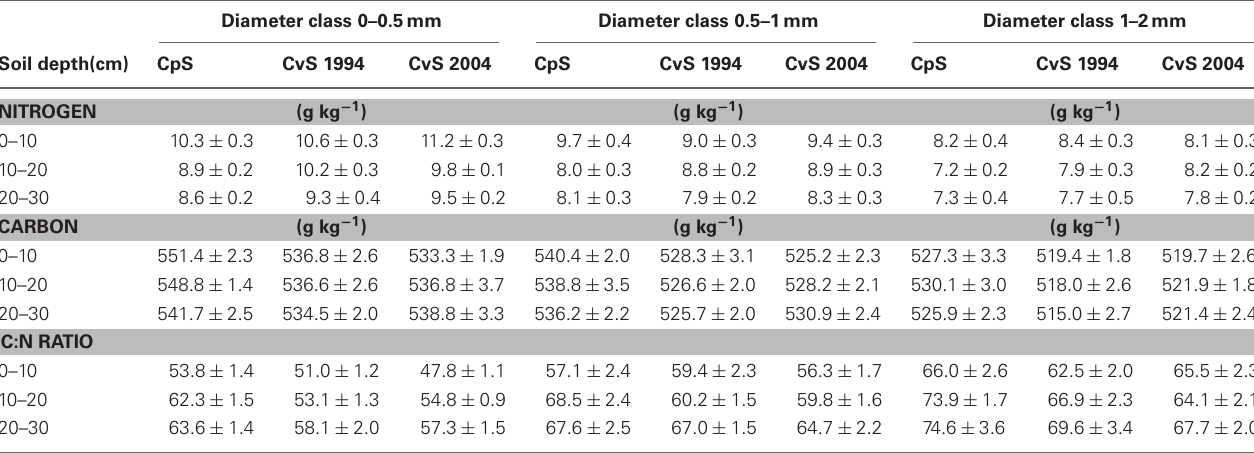
Table A2 | Fine-root nitrogen and carbon concentrations and C:N ratio of three diameter